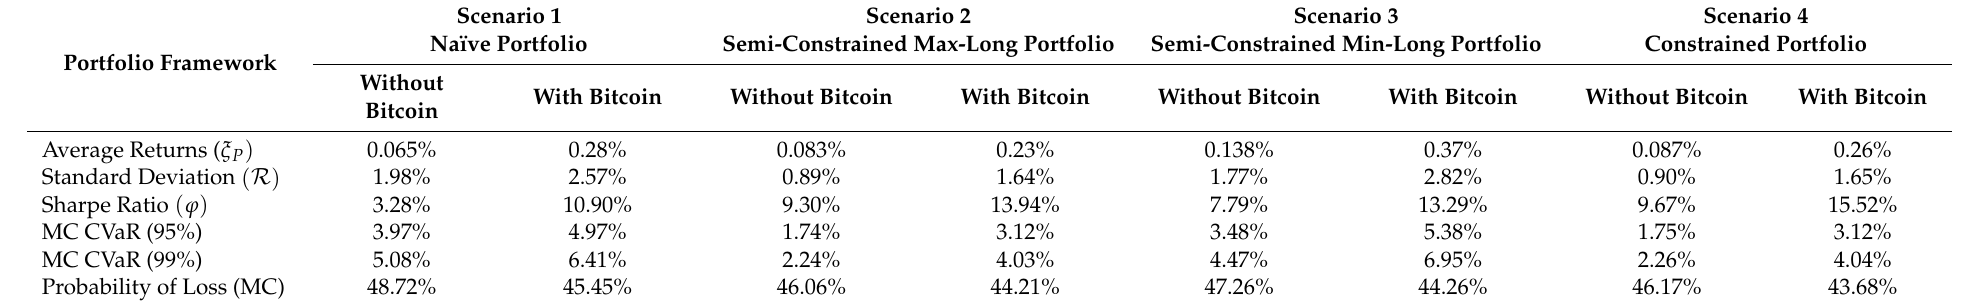
Table 5. Monte Carlo Simulation Results (Scenario 1 to